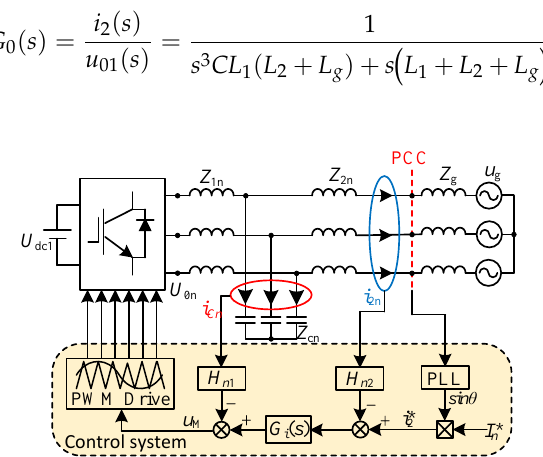
Figure 2. Basic configuration of a single grid-connected inverter.